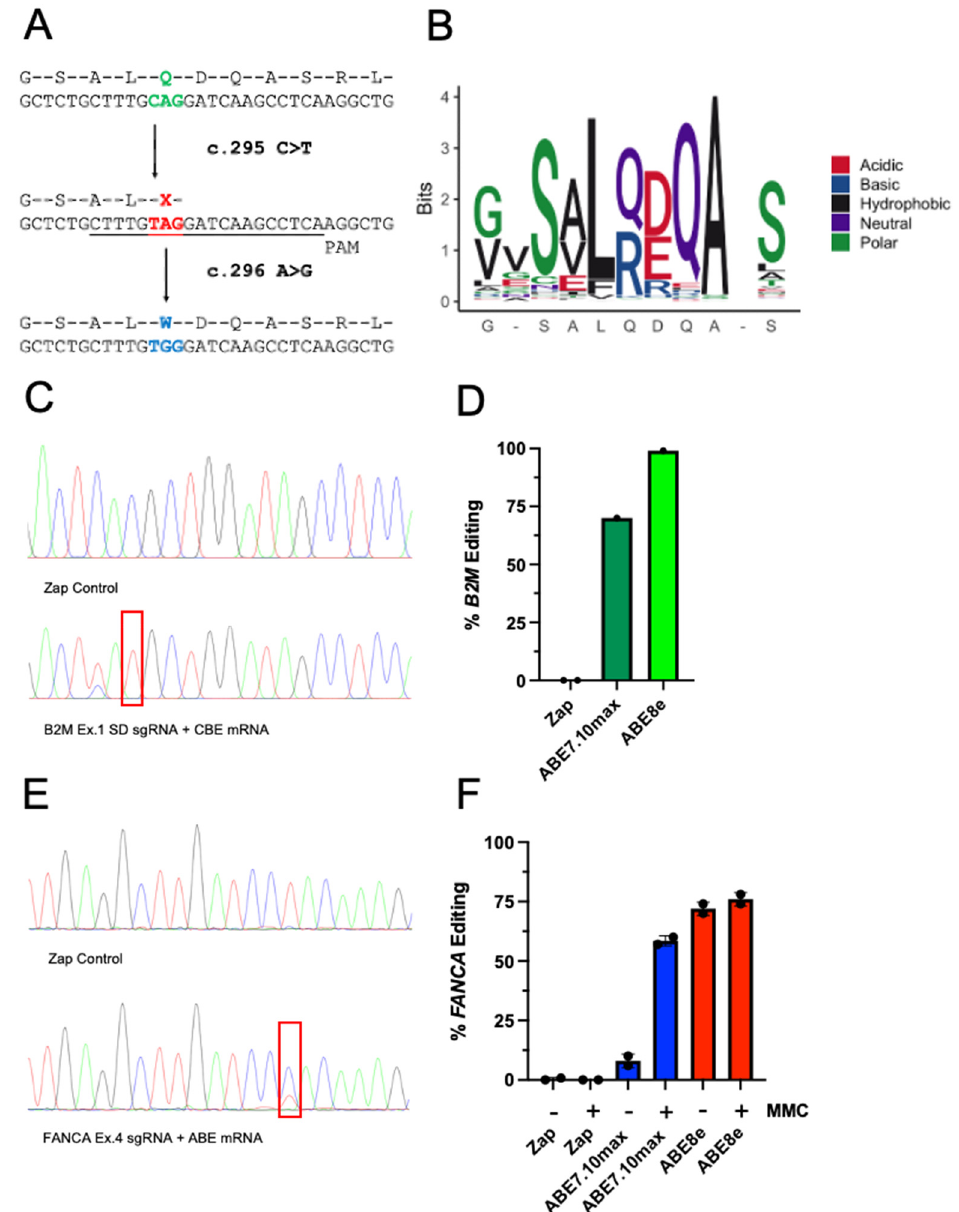
Figure 4. ABE editing in FANCA c.295C > T patient-derived LCL. ( A ) Editing scheme; In FA patient’s with the Spanish founder mutation, a pmSTOP codon (TAG) is mutated from the WT glutamine (CAG). ABE changes this pmSTOP codon (A > G) to tryptophan (TTG) resulting in translation of the FANCA gene. ( B ) Alignment of amino acids surrounding the FANCA c.295 region on exon 4 showing variability of the codon in questions across species. ( C ) B2M Ex.1 SD sgRNA region chromatograms of Sanger sequencing after PCR amplification of B2M exon 1 using EditR. ( D ) Percentage of B2M editing events (http://baseeditr.com/, accessed on 1 January 2018–1 July 2022) identified by Sanger sequencing 5 days post electroporation. Data are represented as mean ± SD with n = 2 and n = 1 replicates, respectively. ( E ) FANCA sgRNA region chromatograms of Sanger sequencing after PCR amplification of FANCA exon 4. Reverse complement primer sequence is shown. ( F ) Percentage of FANCA editing events identified by Sanger sequencing 5 days after electroporation. Data are represented as mean ± SD with n = 2 and n = 1 replicates, respectively. A western blot was then performed to show that the restoration of FANCA protein product was indeed the cause of the FA pathway reactivation and renewed resistance to MMC after BE. After LCL editing, a FANCA band was present albeit to a slightly lower